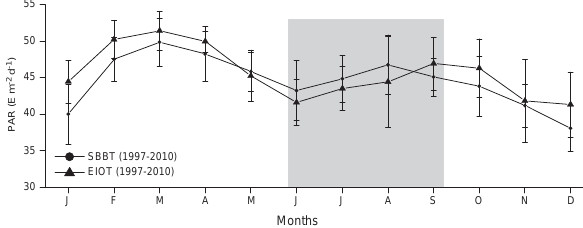
Fig. 4. Monthly mean climatology (1997–2010) of satellite derived chlorophyll pigment concentration at SBBT (filled circle) and EIOT (filled triangle). Shading represents the summer monsoon period (June–September) and vertical lines are one standard deviation.